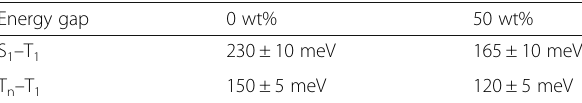
Table 1 Energy gaps determined with a four-level model including a higher triplet excited state (T n ) Energy gap 0